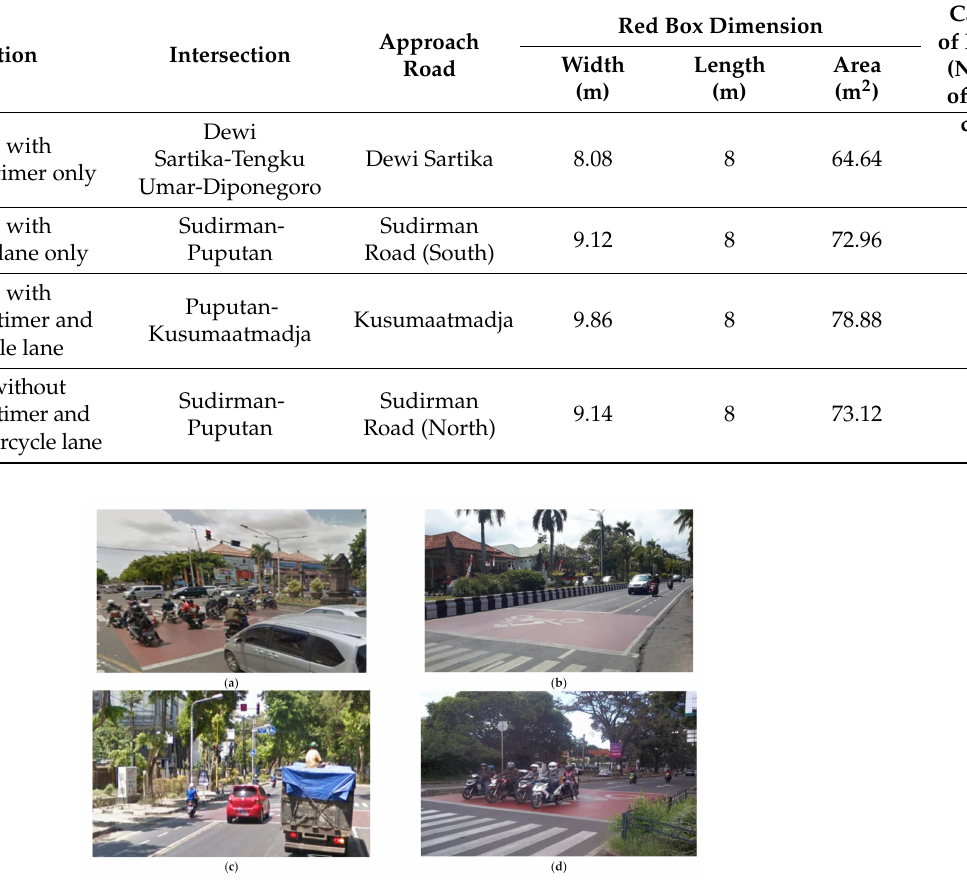
Figure 4. ( a ) Red box with countdown timer only (Condition 1); ( b ) red box with motorcycle lanes only (Condition 2); ( c ) red box with countdown timer and motorcycle lane (Condition 3); ( d ) red box without countdown timers and without motorcycle lane (Condition